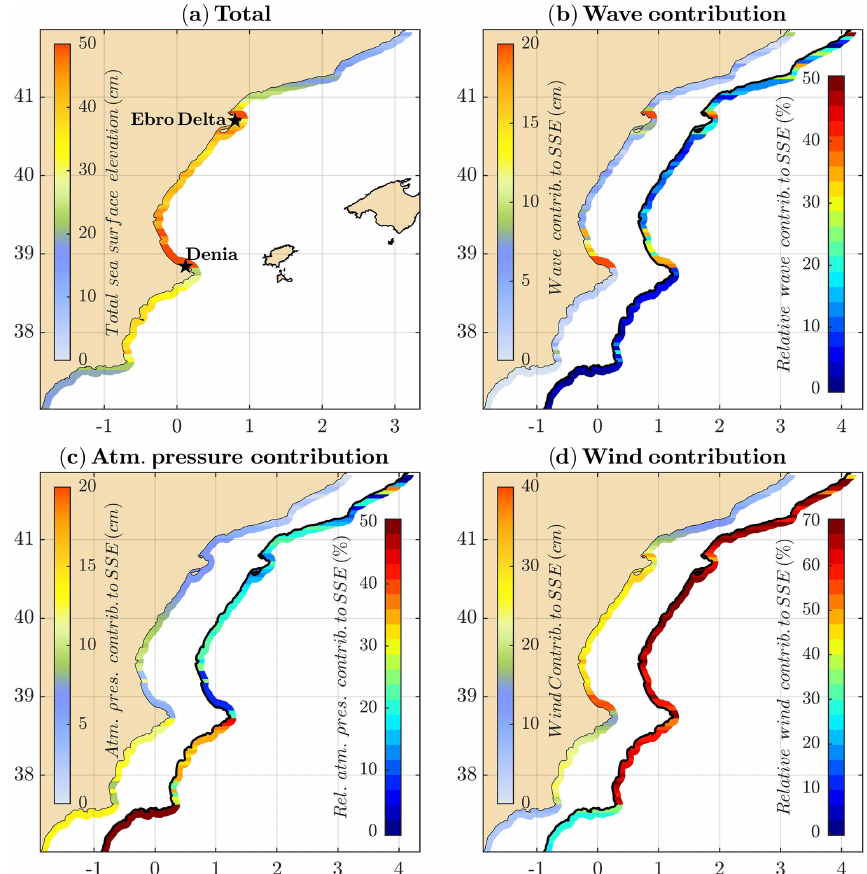
Figure 6. Maximum storm surge along a coastal stripe affected by Storm Gloria (a) and the contributors: wave setup (b) , atmospheric pressure (c) and wind (d) . In panels (b) , (c) and (d) , the absolute (relative) contribution is indicated by the profile on the left (right). Note that the colour scales for the wind have higher